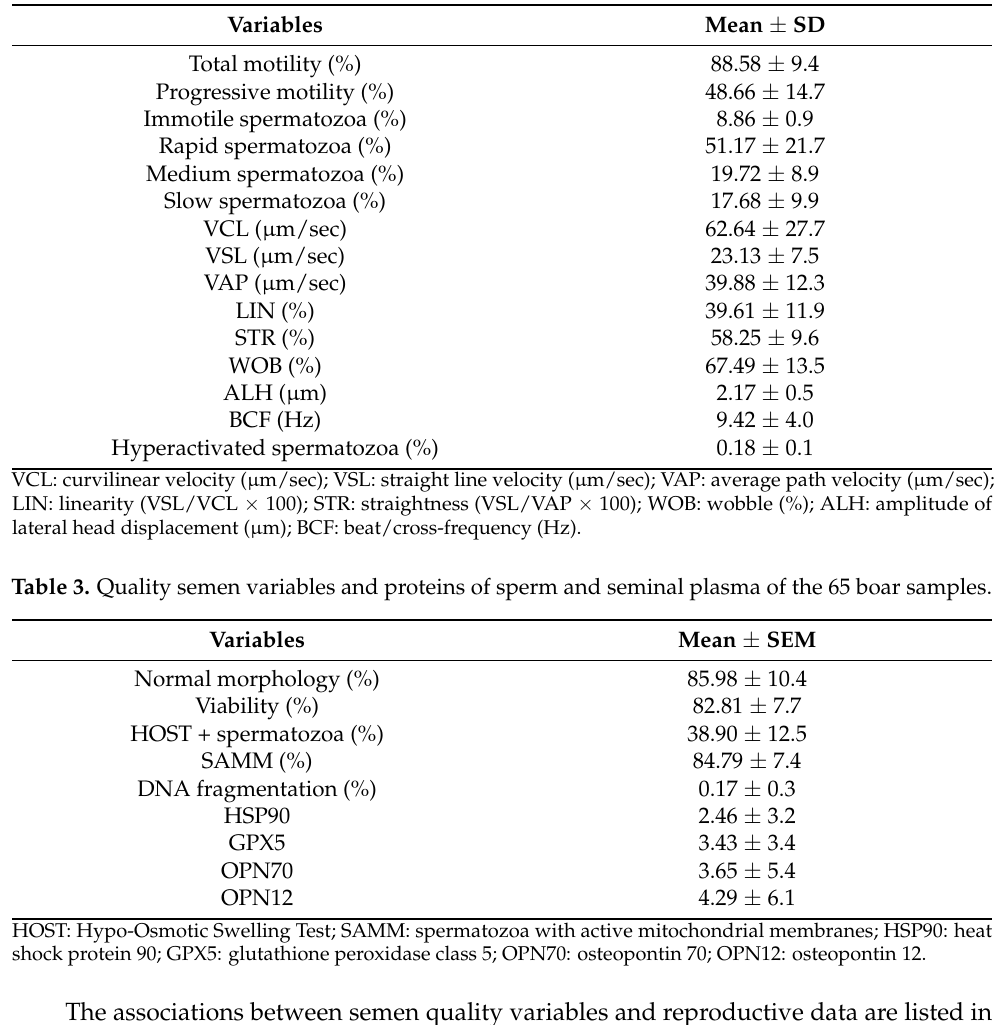
Table 5. The highest coefficient of determination of the present study was observed between live-born piglets and the HOST. The percentage of HOST (+) spermatozoa explained 24.5% ( p = 0.0001) of the variation of live-born piglets and 7.8% ( p = 0.03) of the variation of litter sizes with ≥ 12 piglets. The variation of live-born piglets was additionally explained by the percentage of activated mitochondria ( p = 0.01) by